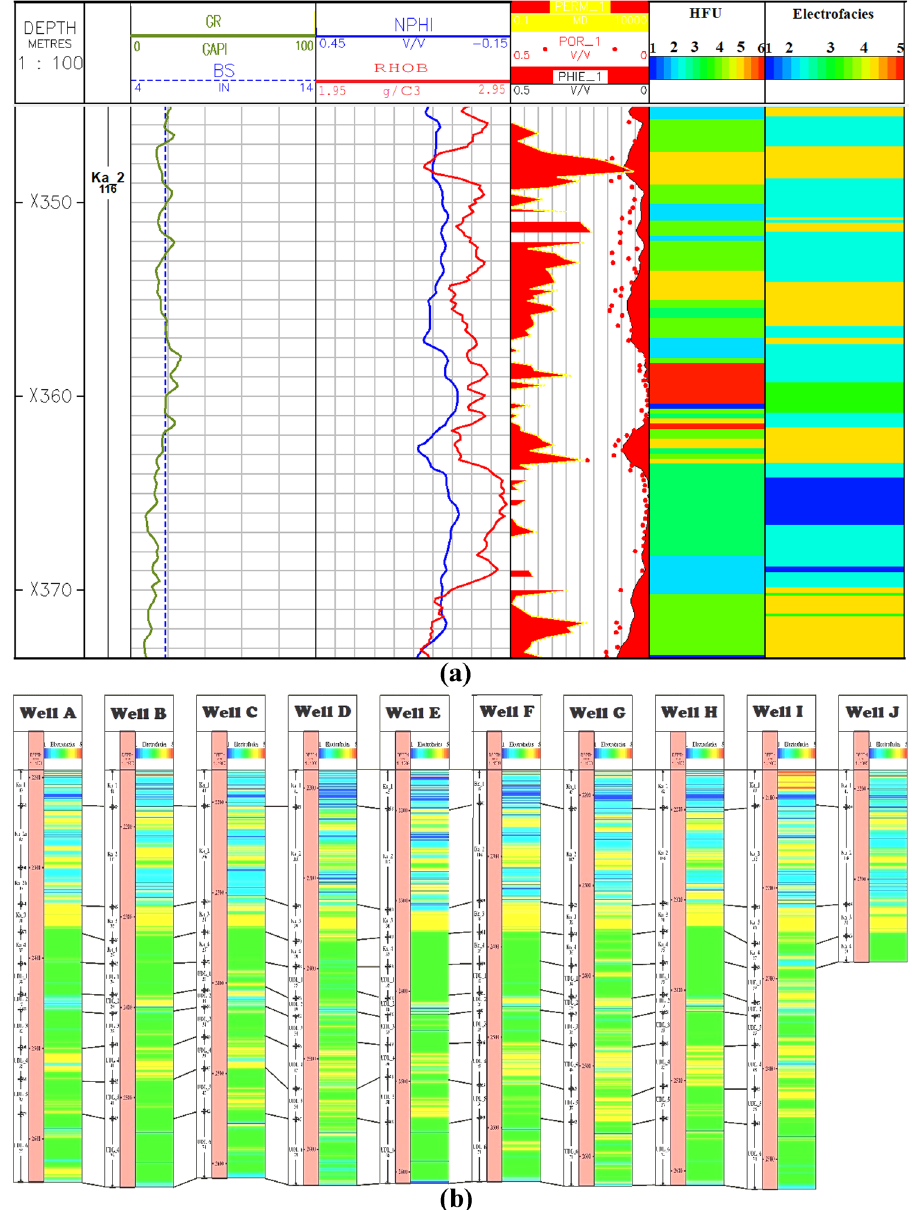
Fig. 18 a Example of a well log with the corresponding electrofacies (EF-1 to EF-5) and hydraulic flow units (HFU 1–6) in well B. The reason for choos- ing this well is the core data, such as porosity and perme- ability, which are available in all depths. This figure shows that the electrofacies in some places contain several different flow units. All HFUs and electrofa- cies color spectrums are shown in this figure except shale electrofacies (EF-5) which are only available in upper depth and have a lower frequency than other facies. Low reservoir quality HFUs that include HFUs 1, 2, and some fraction 3 cor- respond to the low core porosity and permeability values in the left column. b Electrofacies correlation between the ten wells’ sections (see Fig. 18 for color references). The lines of correlation between wells A to J are separated by sub-formations. This separation shows a good connection between all wells and formations, which indicates the high accuracy of the electro- facies